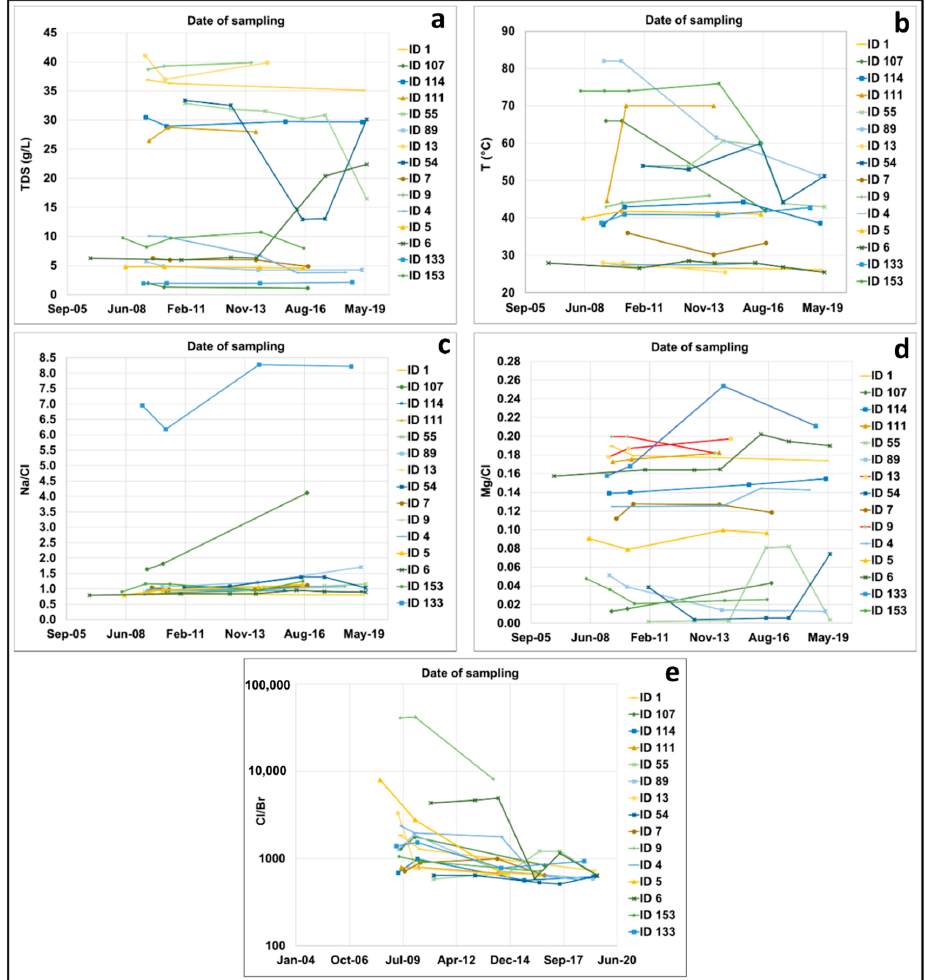
Figure 12. Variation of selected indicators of the quality of the thermal waters of some wells over the period 2006–2019: ( a ) TDS, ( b ) temperature (T), ( c ) Na/Cl, ( d ) Mg/Cl, and ( e ) Cl/Br ratios.